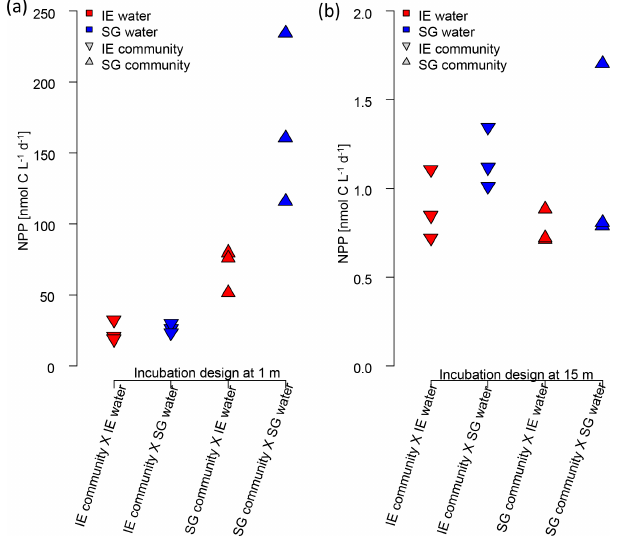
Figure 7. Impact of water source on primary production assessed via a reciprocal transplant experiment. Primary production of IE and SG communities incubated in sterile filtered water originated from either station at (a) 1m and (b) 15m depth. The symbols show the source of the community, and the colors indicate the source of the sterile filtered incubation water. The type of incubation water (color) explains the variation in a nested ANOVA with community (symbol) and depth as nested constrained variables and water source (color) as an explanatory variable ( p = 0.0038; F =